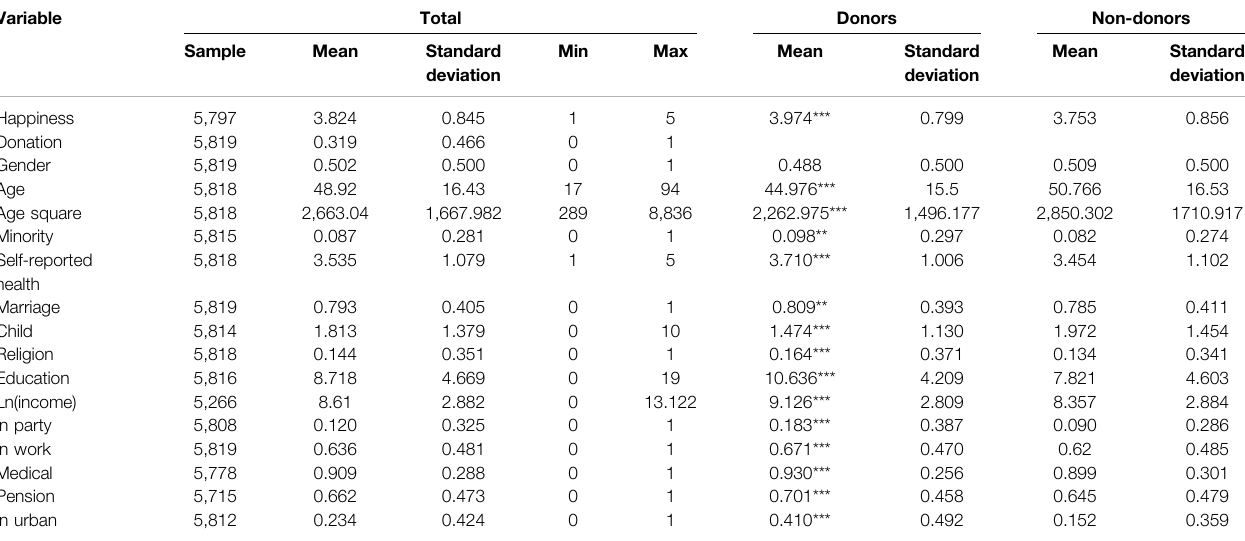
TABLE 1 | Summary statistics.